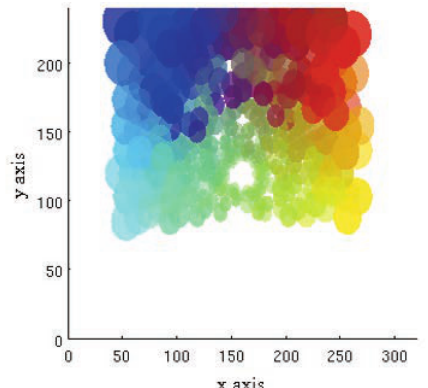
Figure 2. Retina eye map from learning with a single target for 60 minutes with- out any head movement